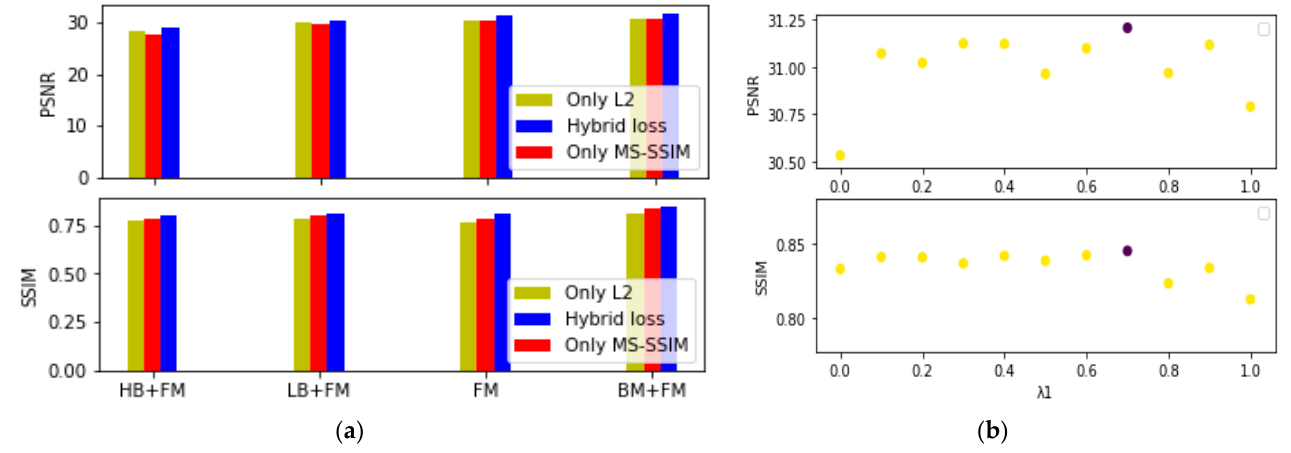
Figure 10. Evaluation of hybrid loss function. ( a ) Performance of L 2 loss, MS-SSIM loss and hybrid loss function on different structures. ( b ) Performance of hybrid loss function under different λ 1 and λ 2 values on proposed framework.